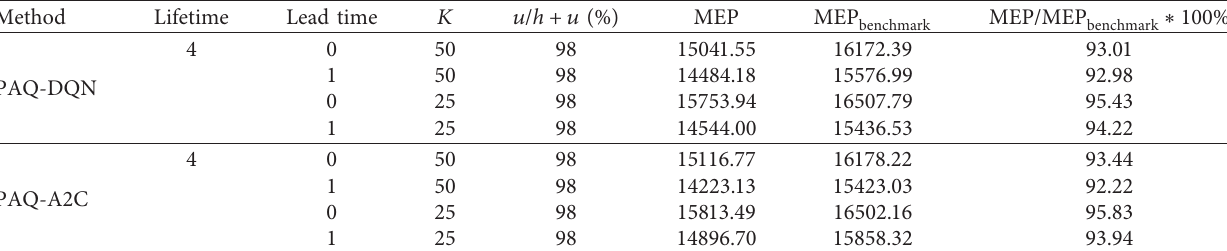
Table 6: MEP with fixed ordering cost.